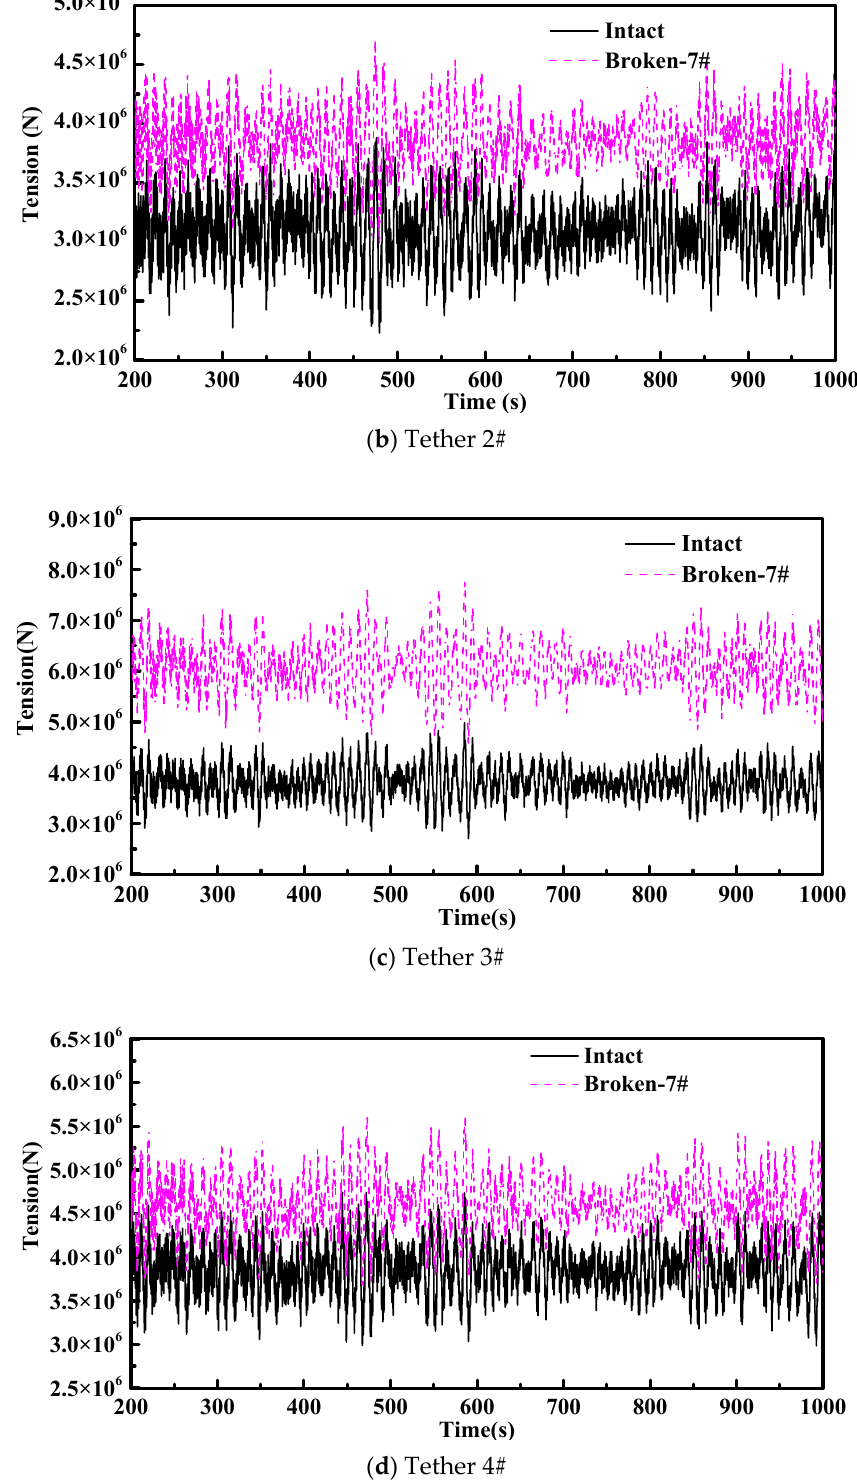
Figure 15. Time series of tether tensions.